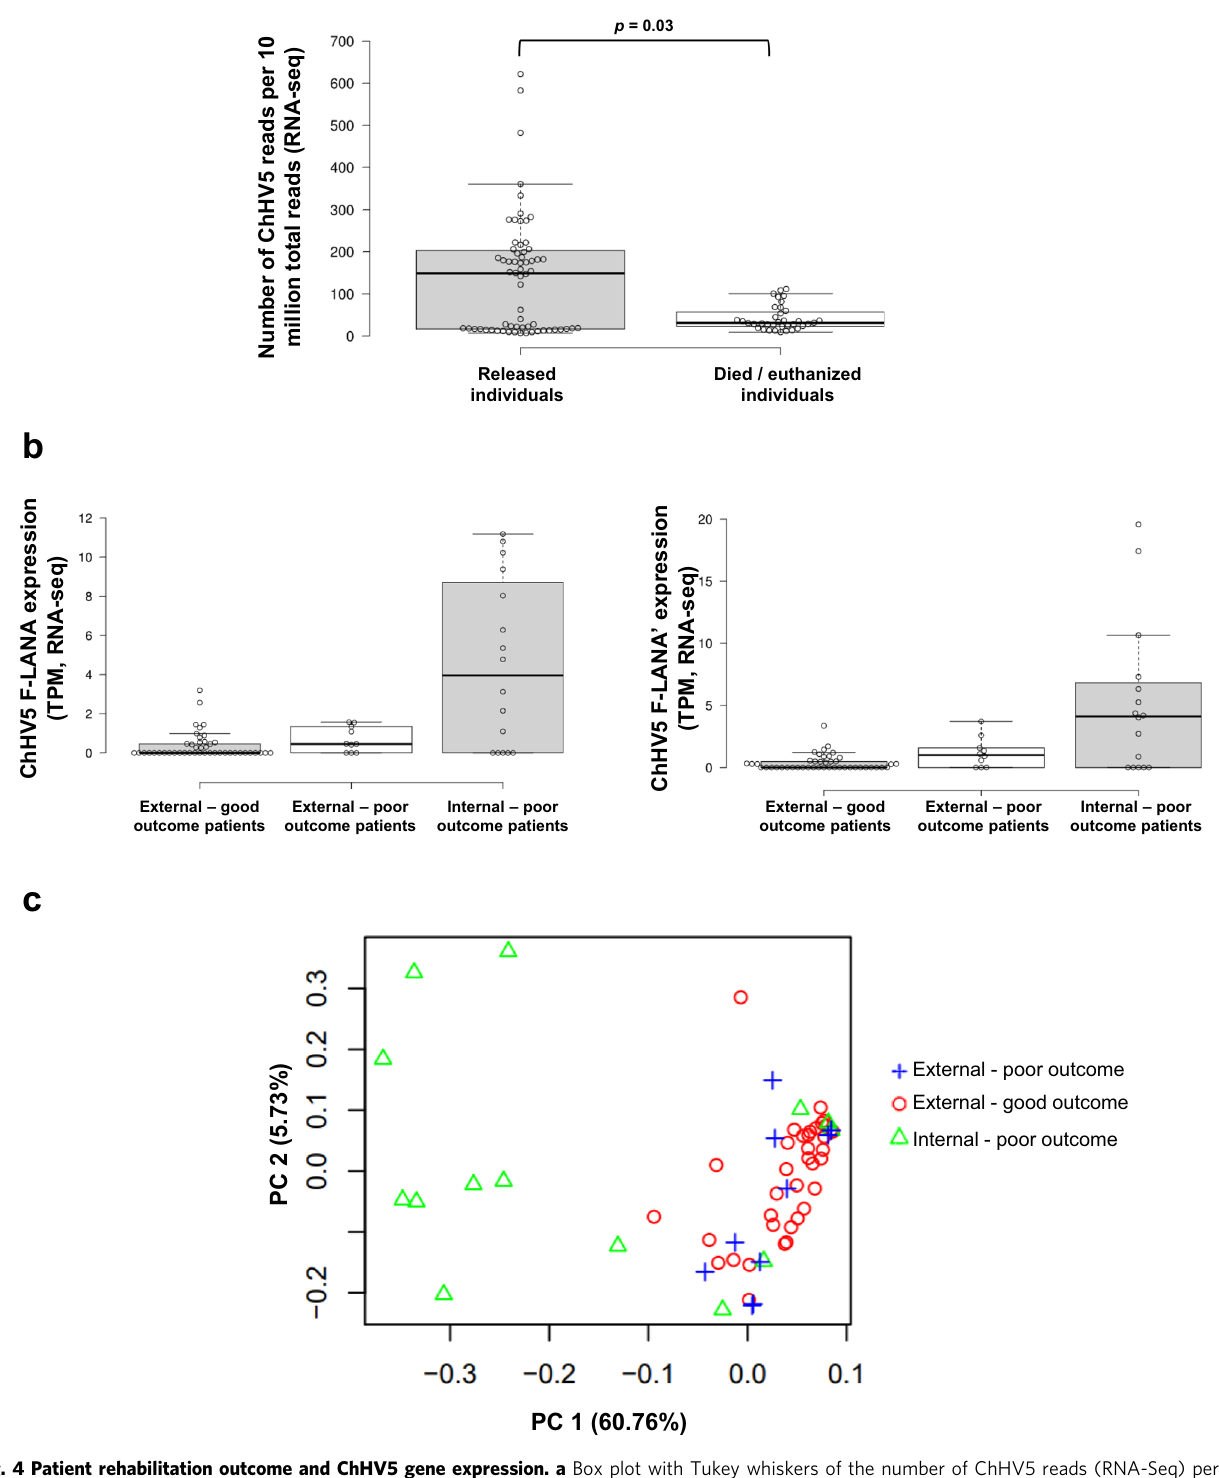
Fig. 4 Patient rehabilitation outcome and ChHV5 gene expression. a Box plot with Tukey whiskers of the number of ChHV5 reads (RNA-Seq) per 10 million total reads between patients based on outcome (released vs died in care/humanely euthanized). Individual sample values within each sample type are shown by the open points. Signi fi cant difference in averages between the two outcomes was determined by a Mann – Whitney U test and is denoted by an asterisk (*). N = 69 samples. Per outcome: released = 7 turtles; died/euthanized = 5 turtles. b Box plot with Tukey whiskers of the expression levels of the ChHV5 F-LANA genes (both copies of the F-LANA gene: F-LANA and F-LANA ’ ) in transcripts per million (TPM), by patient outcome and tumor location, as detected by RNA-seq. Individual sample values within each sample type are shown by the open points. c Principal component analysis (PCA) of the viral transcriptomes (minus 28 genes which had 0 reads across all samples, see methods) of all tumor samples (RNA-seq), by tumor location and patient